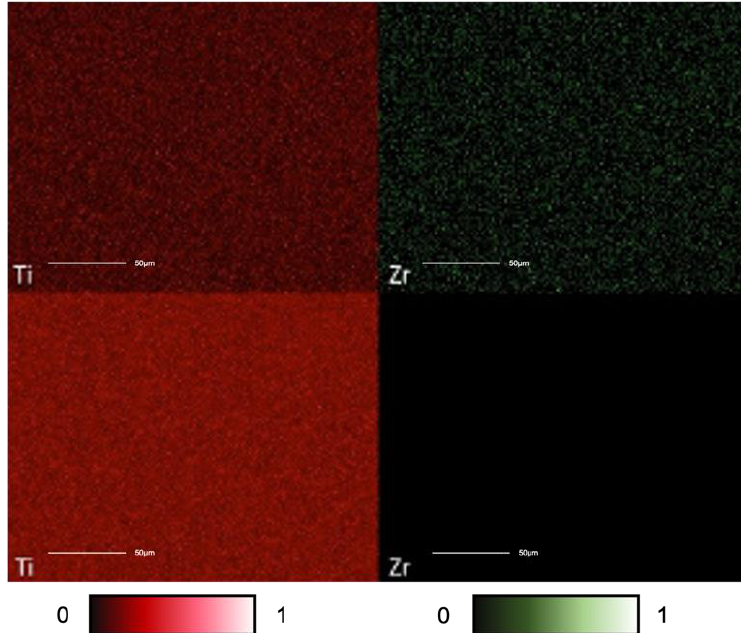
Figure 2. EDS elemental maps. The analysis was performed to evaluate the presence of both titanium (Ti) and zirconium (Zr) on the surface of the discs. The pictures on the top show the map distribution of the elements on the coated samples (T2), while the ones on the bottom are for the uncoated samples (T1). Each element is presented with different color intensity according to its distribution within a greyscale. Titanium (Ti) and zirconium (Zr) are presented in red and in green, respectively. As expected, zirconium (Zr) was absent on T1 surfaces. Scale bar 50 µ m.